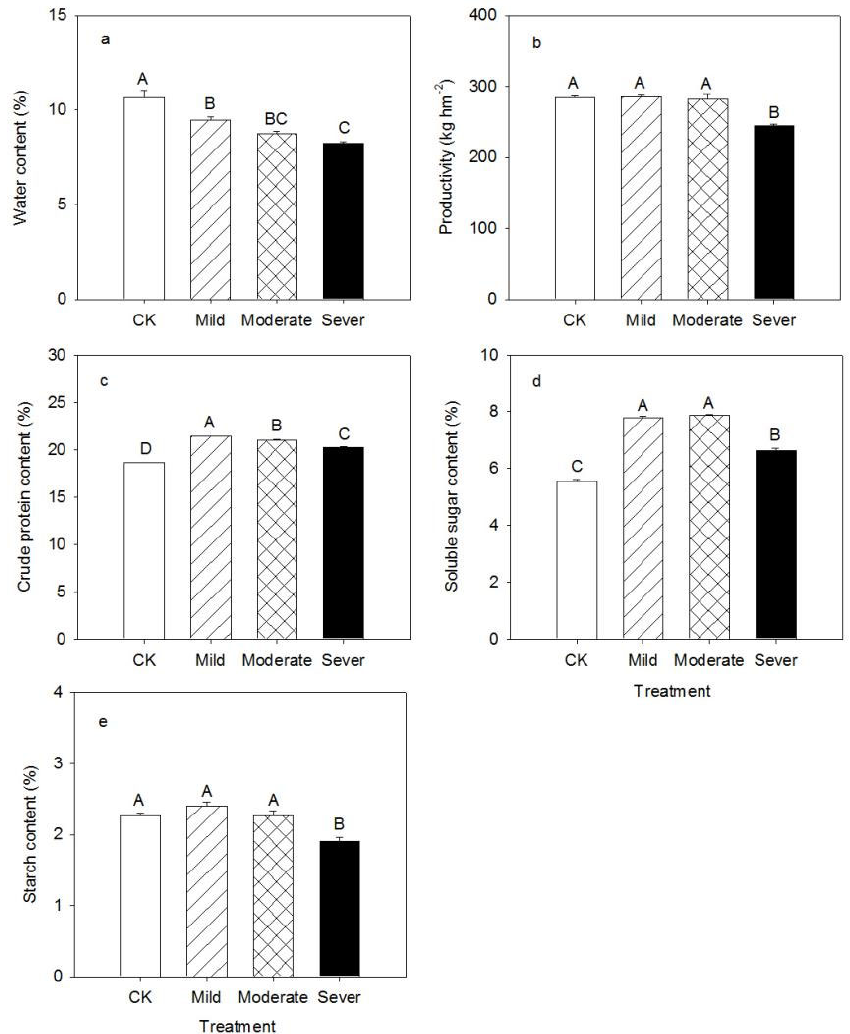
Figure 1. Effects of salt stress (CK, mild, moderate, and severe) on plant water content ( a ), produc- tivity ( b ), crude protein content ( c ), soluble sugar content ( d ), and starch content ( e ). Values are means ± SEs. Significant differences between different levels of salt stress are indicated by uppercase letters ( p < 0.05). Table 2. Correlation analysis of physiological characteristics and soil N under different salt stresses.